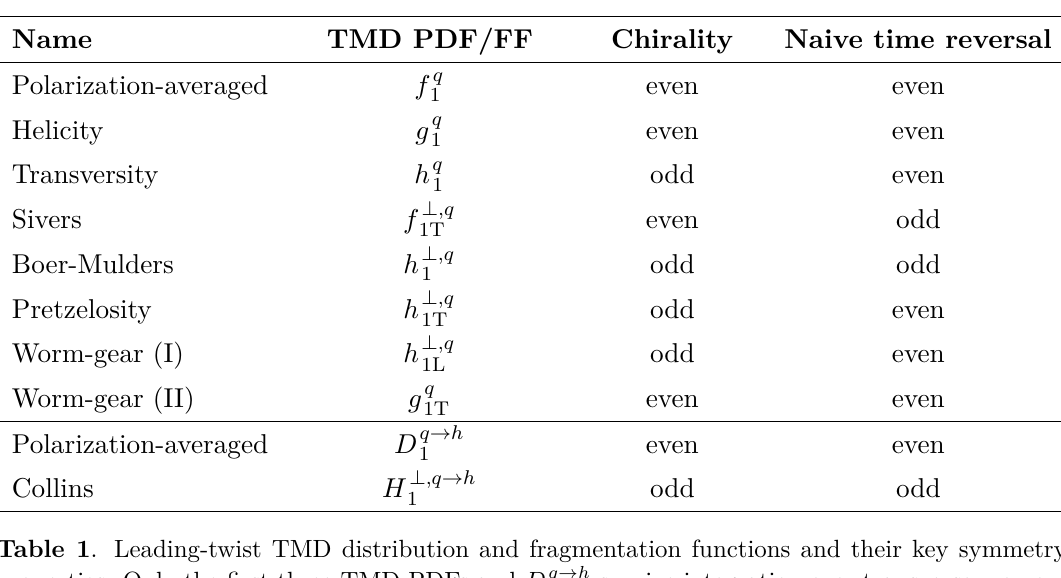
survive integration over transverse momen- 1